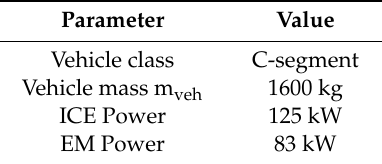
Table 1. Vehicle